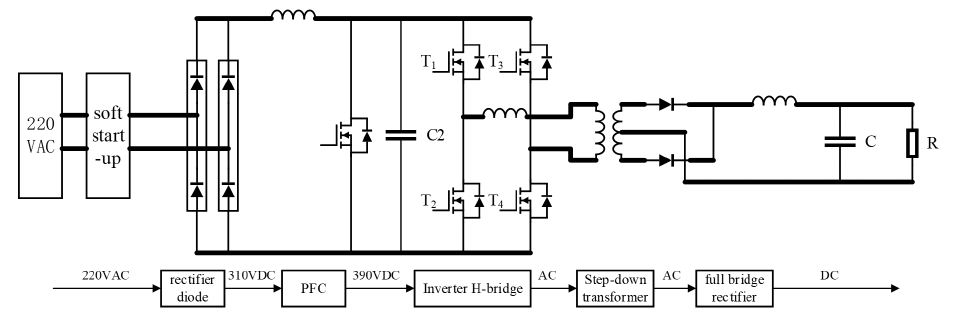
Figure 4. The topology of the power